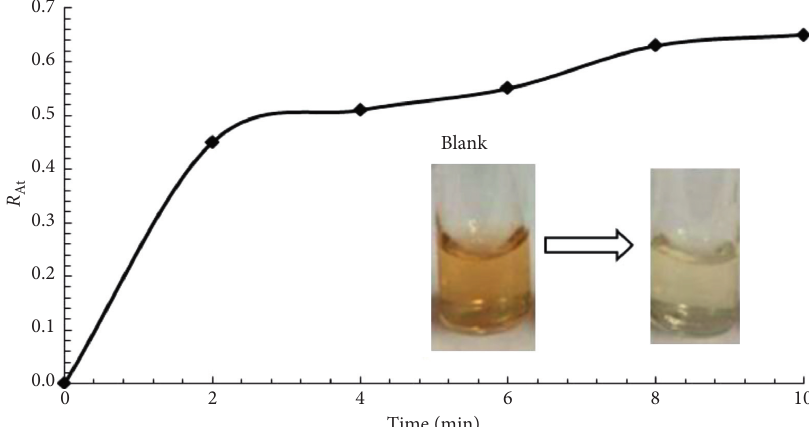
Figure 8: Relative change in absorbance, R